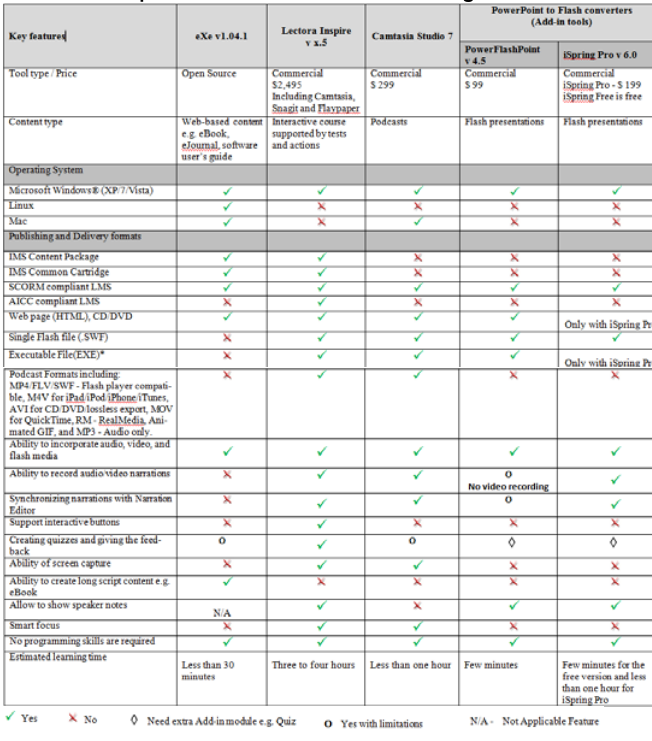
Table 2: Comparison between content authoring tools -